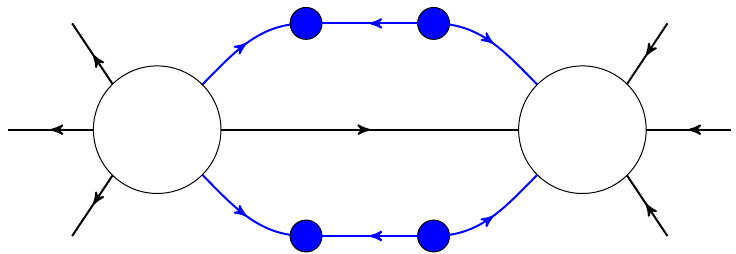
Figure 10. Graphical representation of the density matrix of the region A from figure